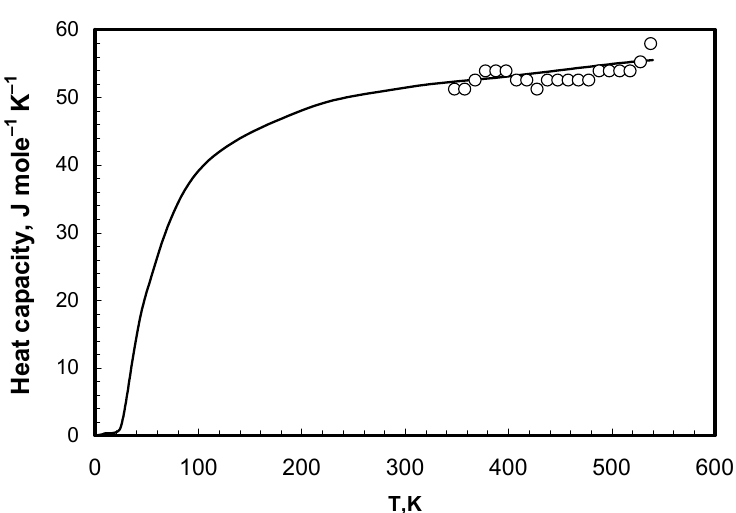
Figure 2. Heat capacity of the solid LiBr-CsBr eutectic mixture. ○ —our data, line—values calculated according to additive law using literature data [8,19].